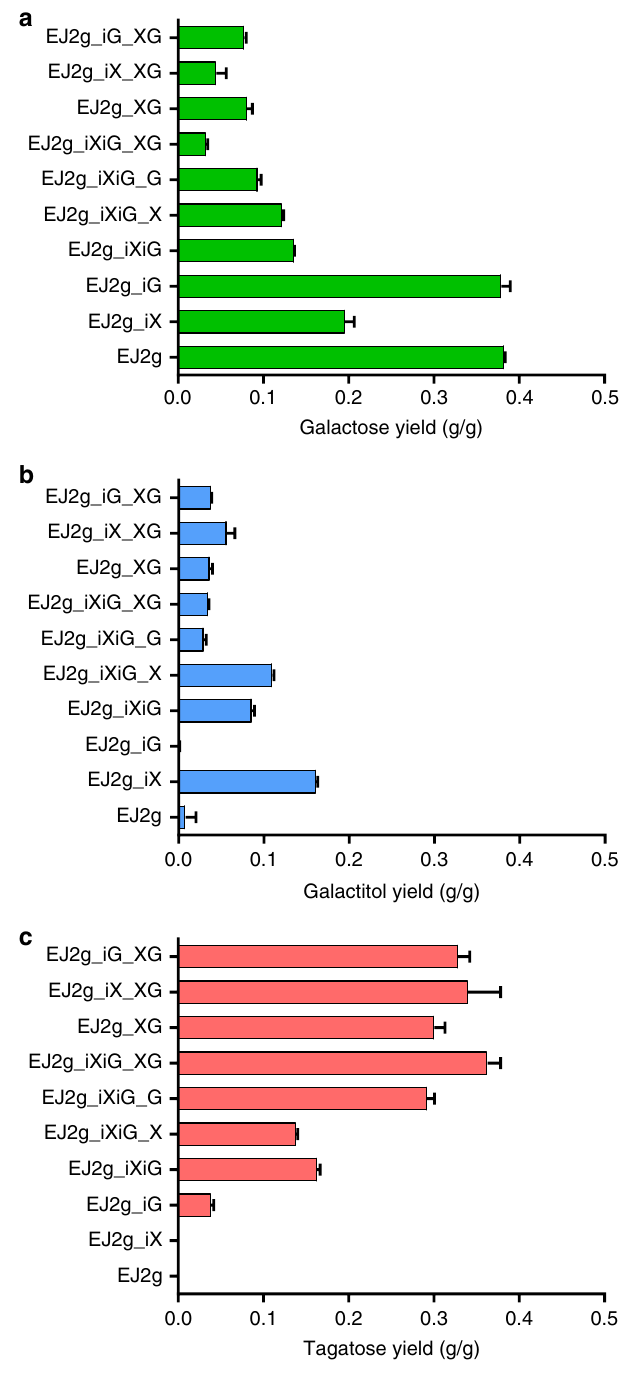
Fig. 4 Improved production of tagatose by increasing the XR and GDH gene copy numbers. a Galactose yield, b galactitol yield, and c tagatose yield. Data are presented as mean value and standard deviations of three independent biological replicates. Source data are provided as a Source Data fi le